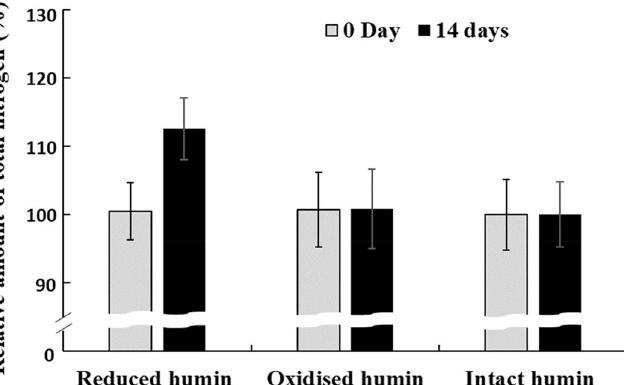
Figure 4. Effect of humin preparation on the nitrogen fixation activity of the no-humin consortium, tested using reduced, oxidised and intact humin, as shown by the change in relative nitrogen content during 14 days of incubation. Gray bars denote the nitrogen contents at 0 day (100%), and black bars denote those after 14 days. The humin used here was Kamajima